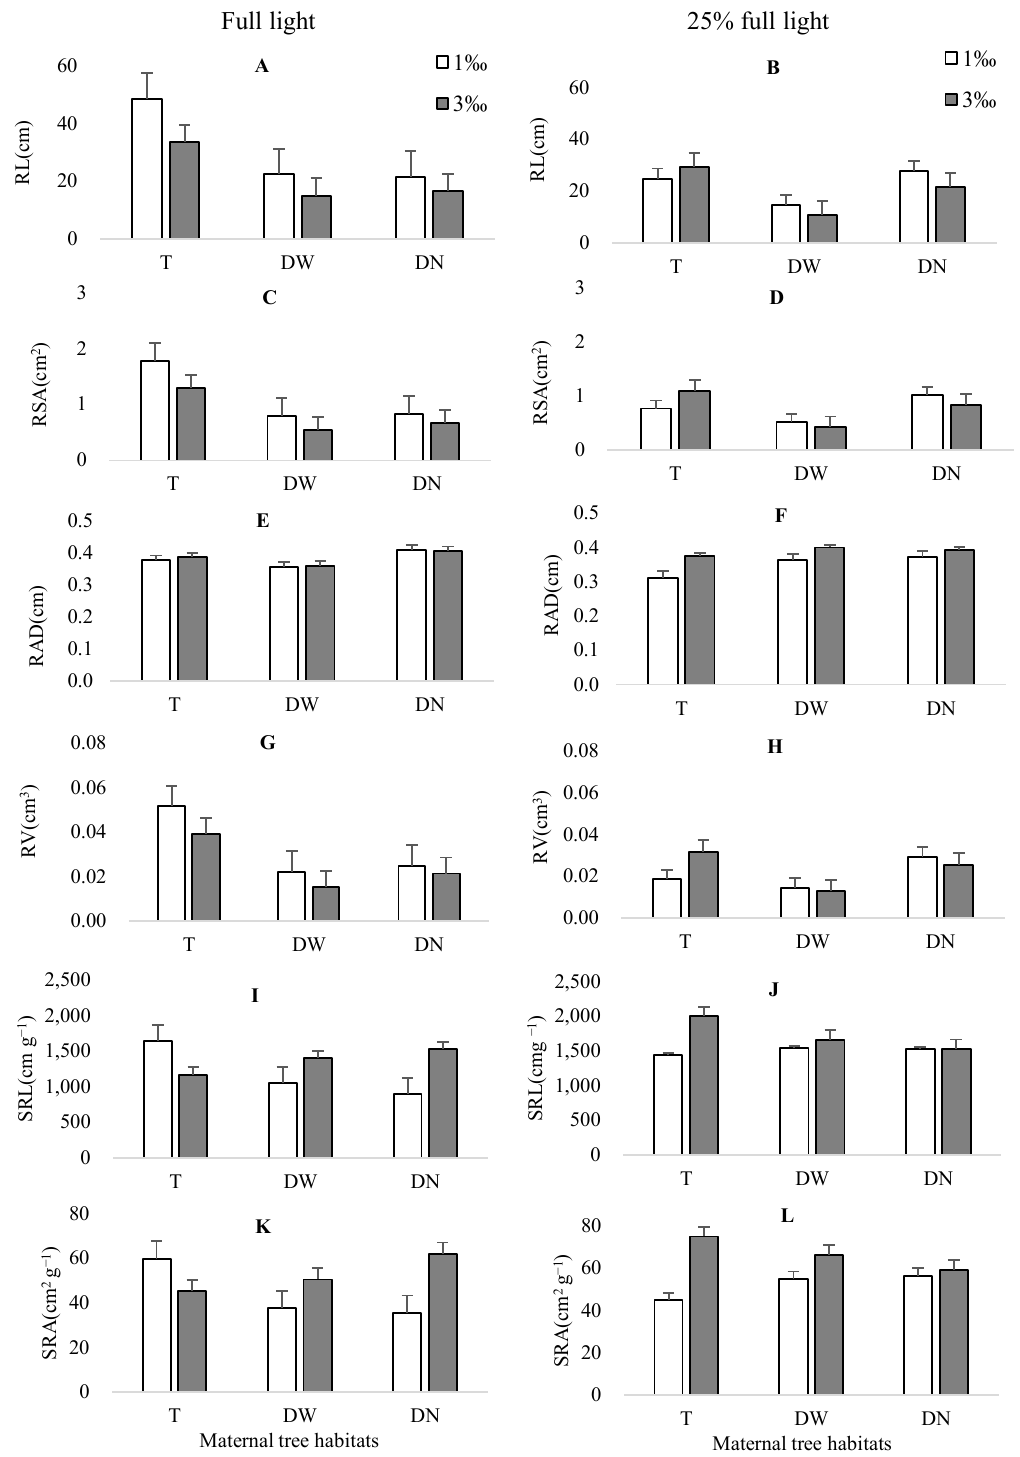
Figure 6. Effects of light intensity and salt content on root of Morus alba seedlings morphology from different maternal tree habitats. T: seeds from nonsaline soil; DW: seeds from Jiufenchang in saline–alkali land; DN: seeds from Shenxiangou in saline–alkali land. ( A ): RL, full light; ( B ): RL, 25% full light; ( C ): RSA, full light; ( D ): RSA, 25% full light; ( E ): RAD, full light; ( F ): RAD, 25% full light; ( G ): RV, full light; ( H ): RV, 25% full light; ( I ): SRL, full light; ( J ): SRL, 25% full light; ( K ): SRA, full light; ( L ): SRA, 25% full light.